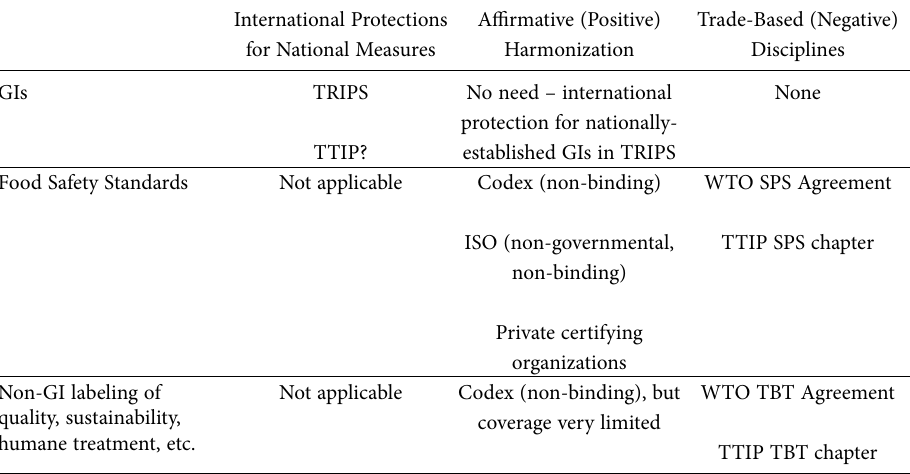
Table 1. Comparison of international legal standards for GIs, food safety standards, and non-GI claims of food